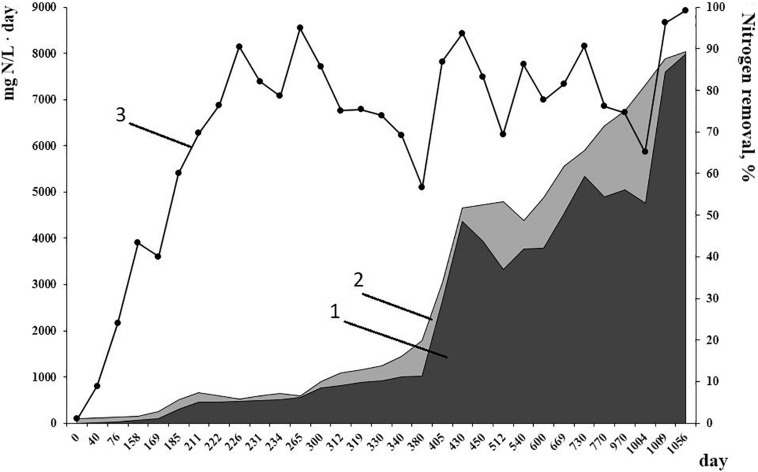
Nitrogen load (1) and nitrogen removal (2) rates, mg N/L⋅day, from 1 to 1056 day of reactor performance. (3) Efficiency of nitrogen removal, %.